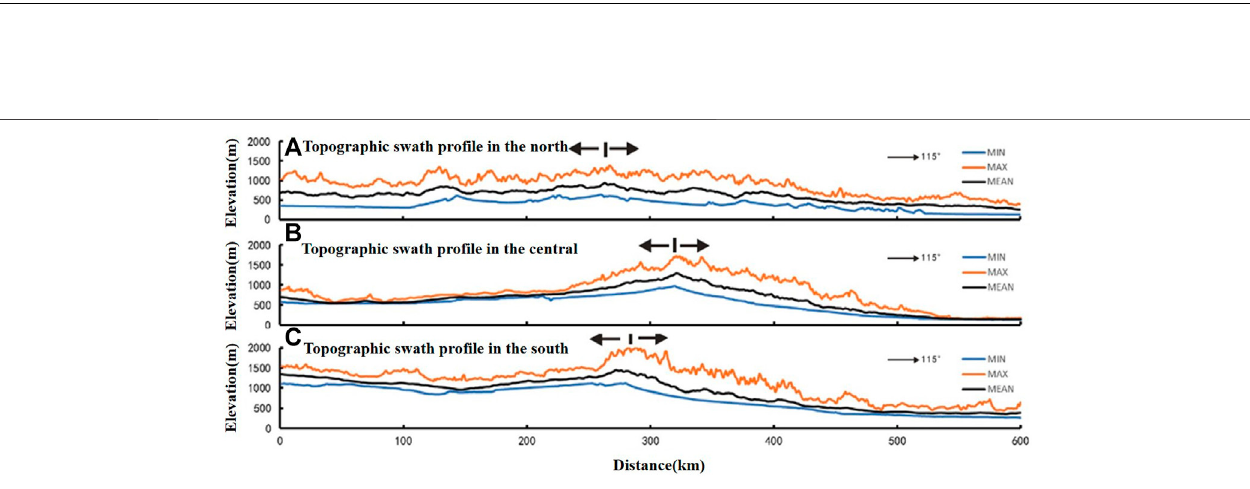
FIGURE10| Transverseswathpro fi lesacrossdifferentsegmentsoftheGreaterKhinganMountains. Theswathis100 kmwideand600 kmlong.See Figure1 for locations. (A) North swath pro fi le; (B) central swath pro fi le; (C) south swath pro fi le.